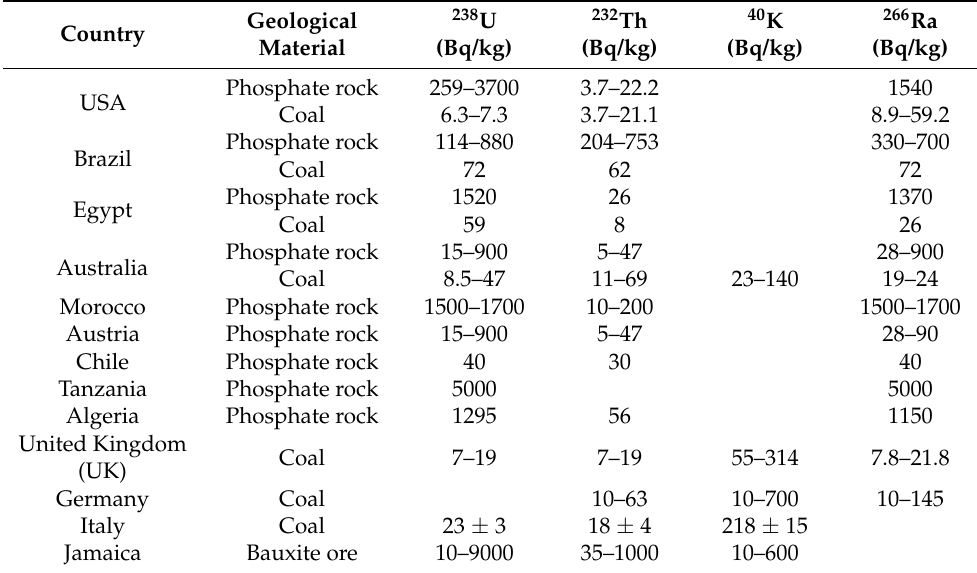
Table 1. Activity concentration of NORM in some geological materials worldwide